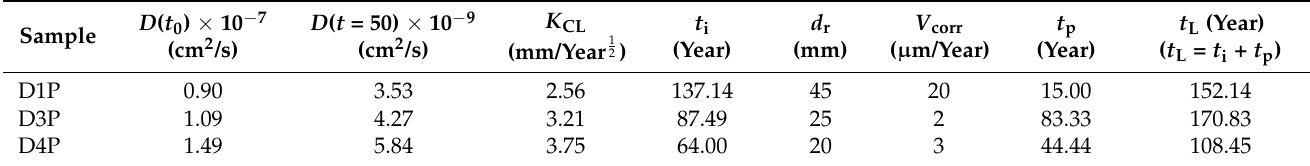
Table 10. Application of the chloride penetration model for the general calculation method of the useful life according to data included in the EHE-08.